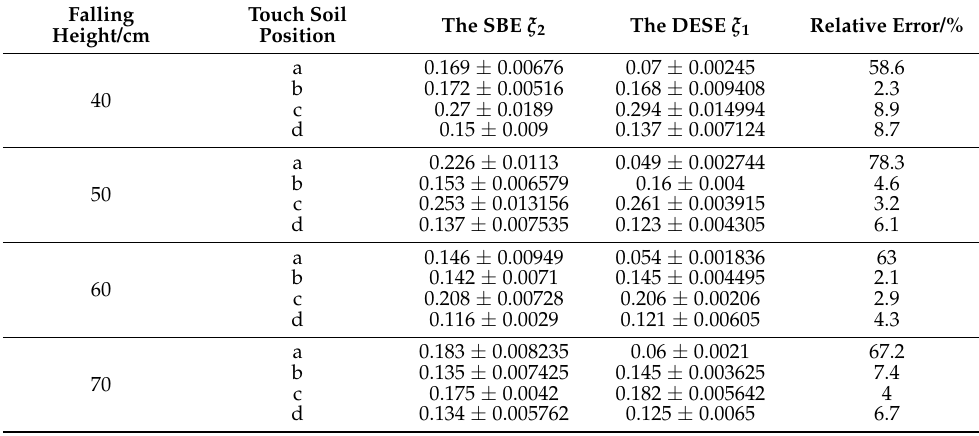
Table 5. Comparison of results of the SBE and the